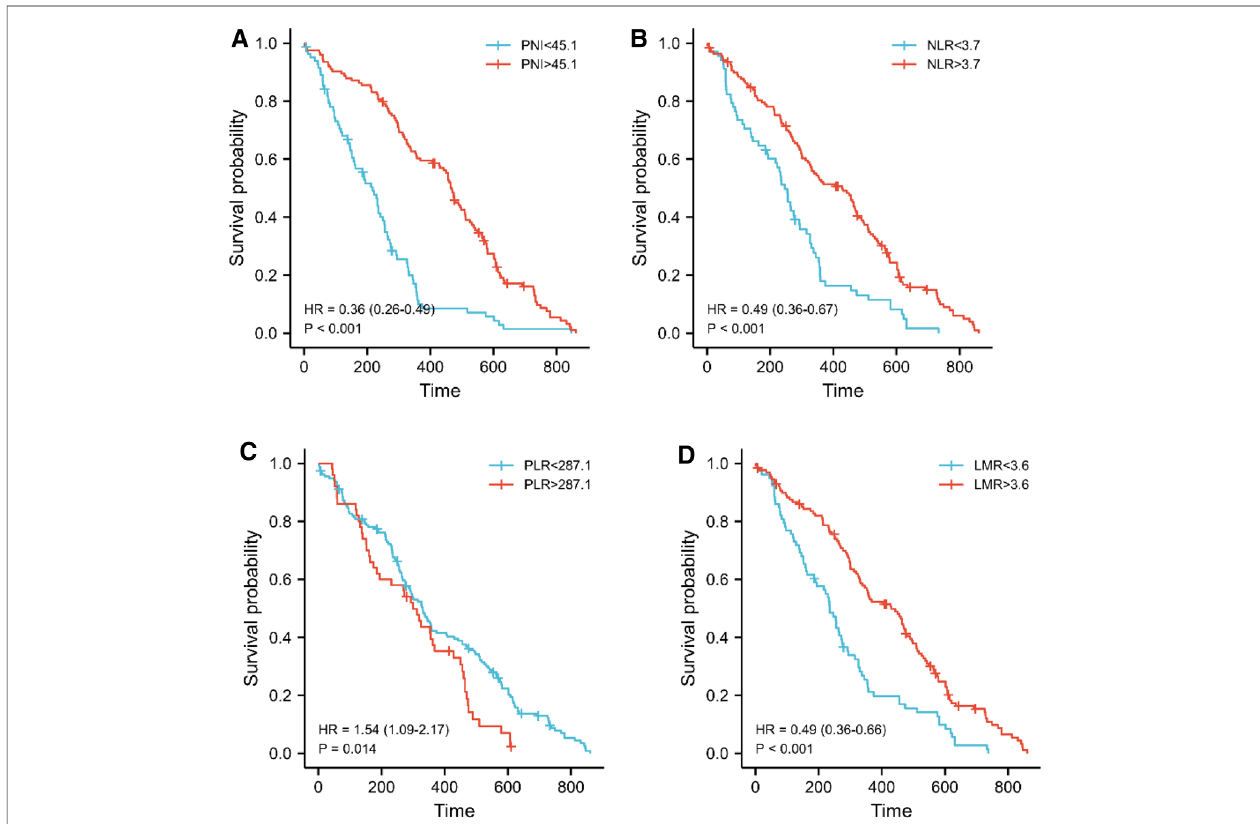
FIGURE 3 | PNI was linked to overall survival in pancreatic head carcinoma patients. ( A – D ) Kaplan-Meier survival curve for all patients. The median values of PNI, LMR, NLR and PLR adopted the previous cutoff values. The p -value was calculated by the log-rank